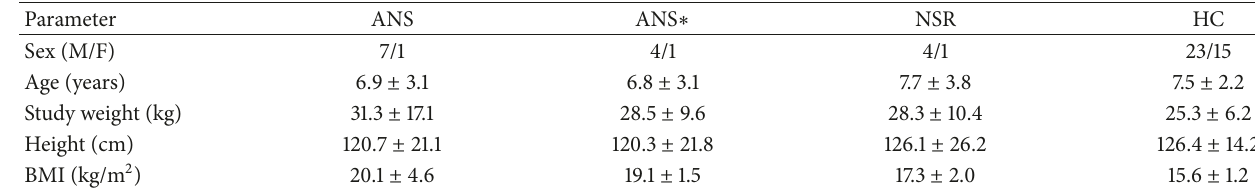
Table 2: Characteristics of the subjects enrolled in the study.